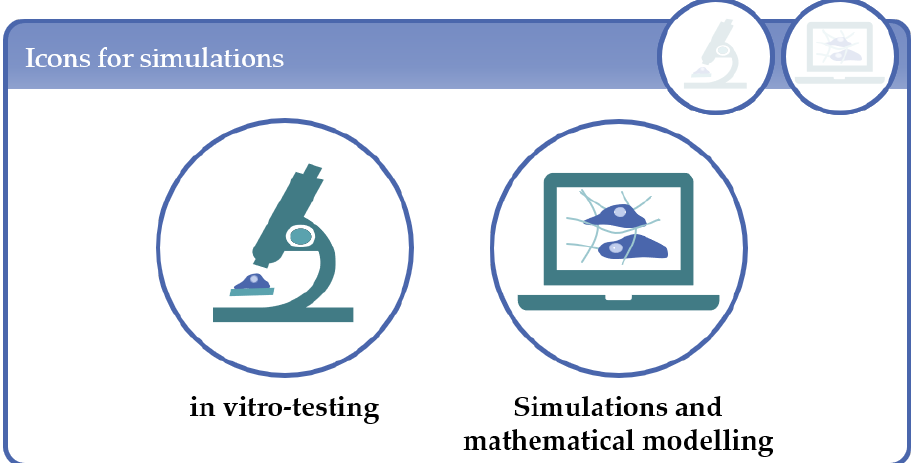
Figure 25. Icons for the classification of publications with a simulation component. Left: the icon for in vitro experiments in addition to the simulations, right: the icon for publications that use simulations or computational methods.